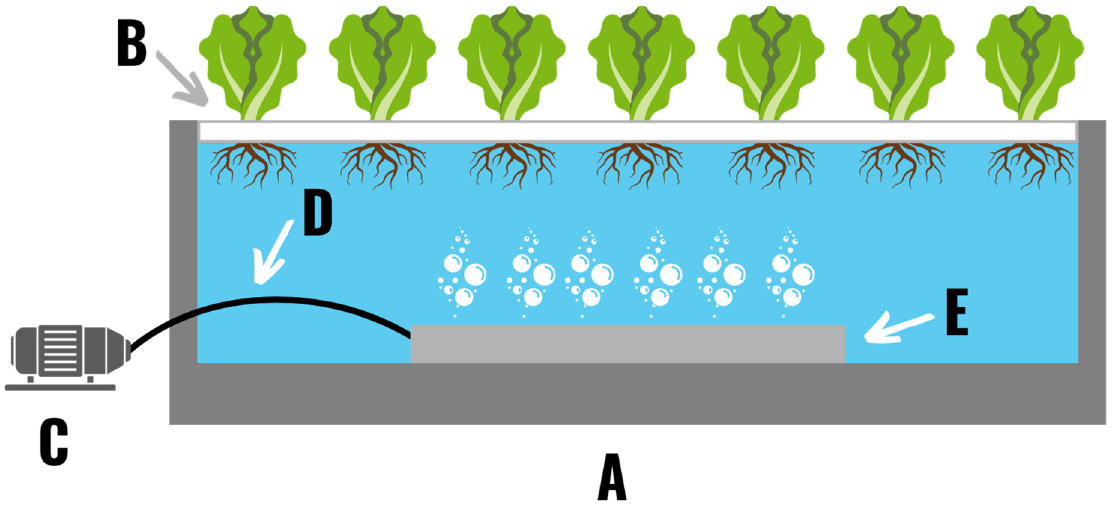
Figure 7. A deep-water culture hydroponic system comprised of a reservoir ( A ), a floating raft ( B ), an air pump ( C ), an airline ( D ), and a bubbler ( E ). Plants are placed in the grow raft and suspended in the nutrient solution. Proper oxygenation of the root zone is ensured by bubbling air through the nutrient solution.